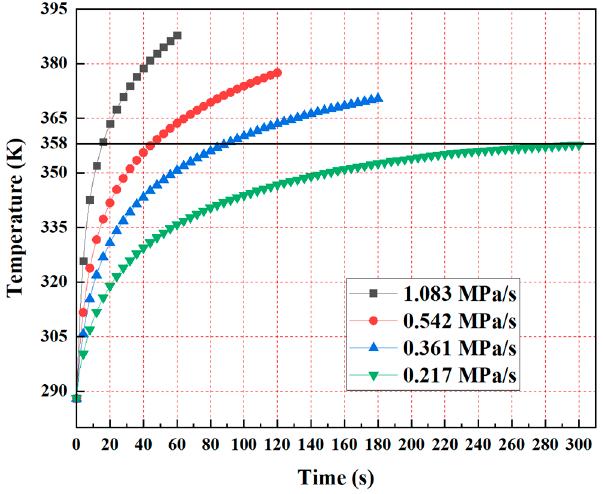
Figure 9. Evolution of the hydrogen temperature rise at di ff erent fi lling rates.